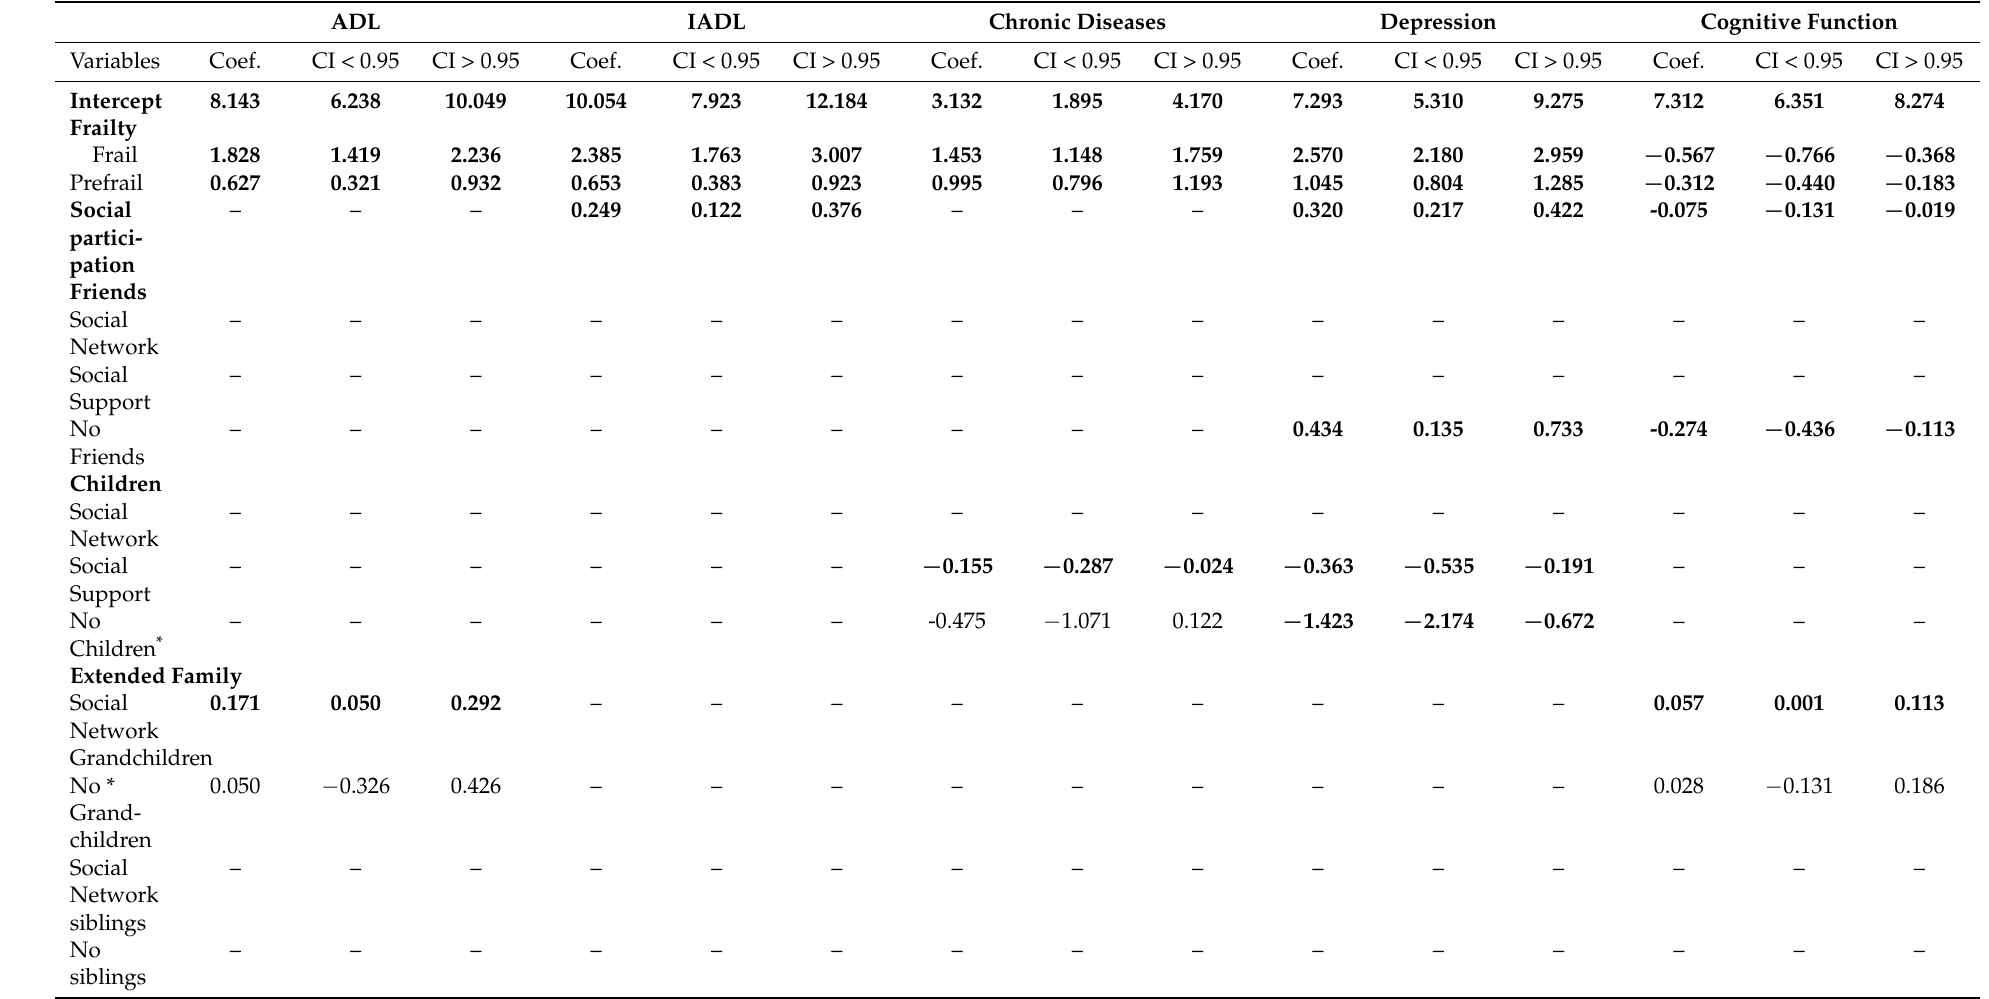
Table 3. Regression of social isolation and frailty on health